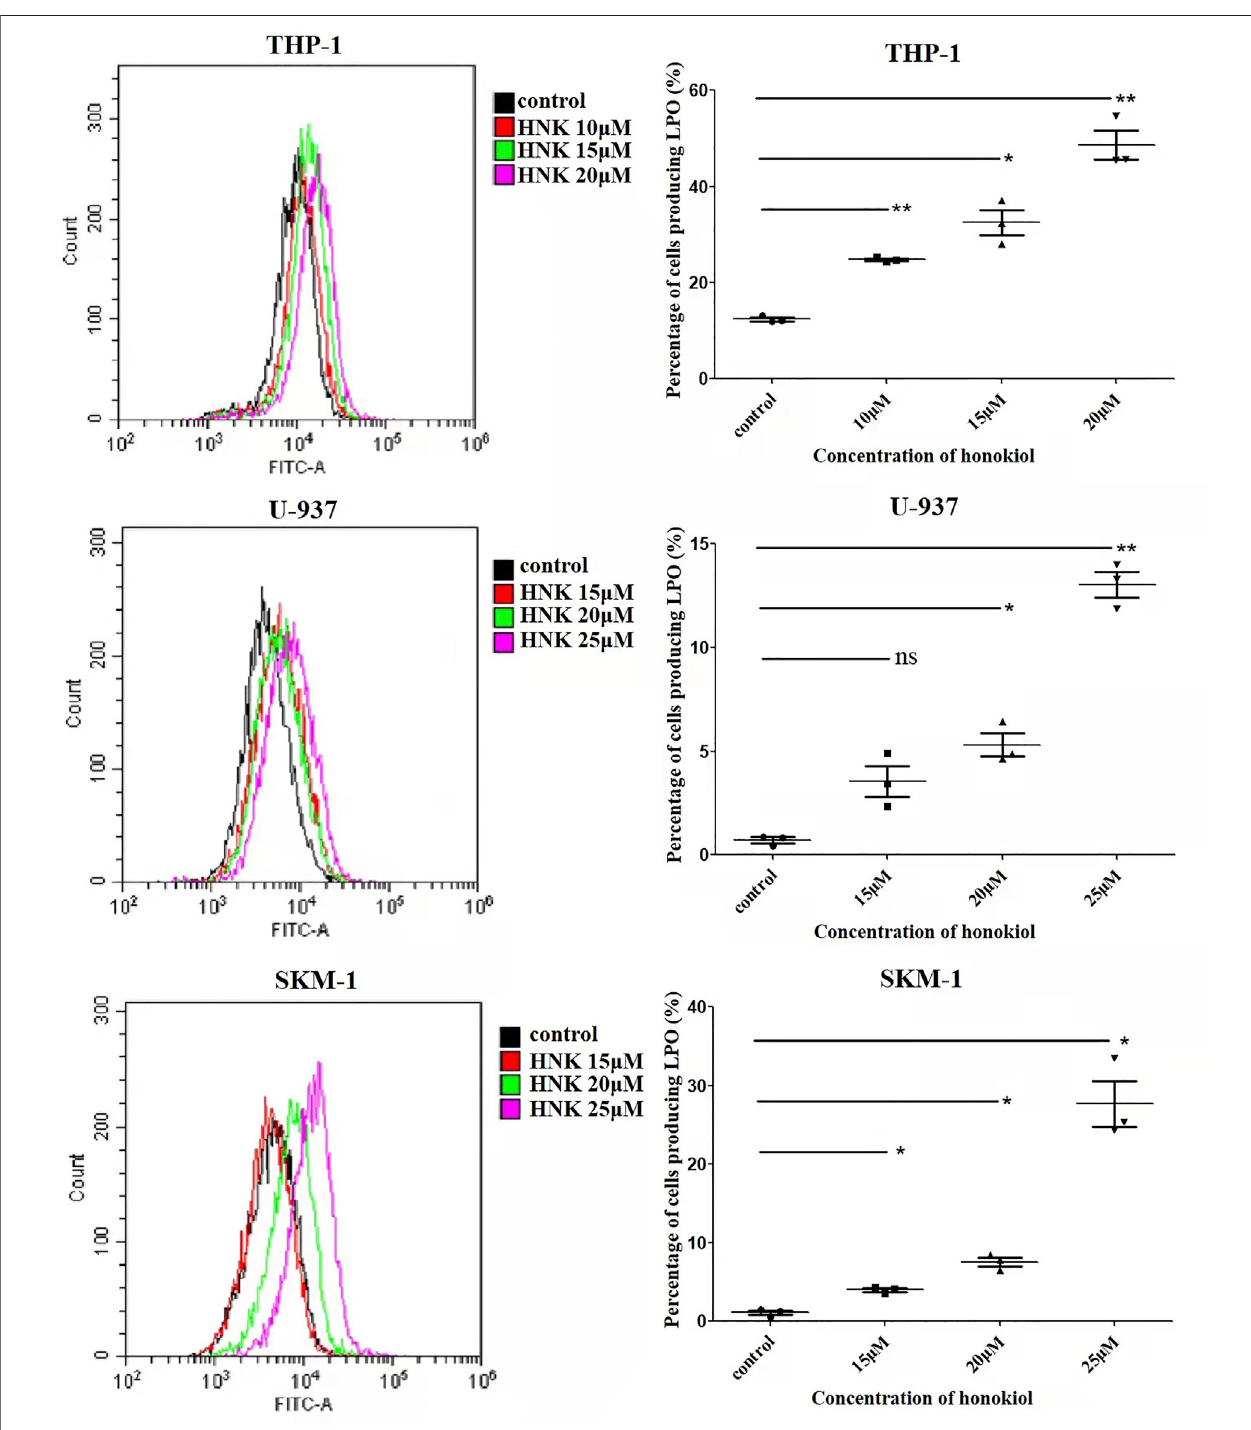
FIGURE 6 | Effects of honokiol on lipid peroxidation in THP-1, U-937, and SKM-1 cells. The cells were incubated with different concentrations of honokiol for 24h, then liper fl uo was added for fl ow cytometry analysis. Statistical analysis of lipid peroxide was presented as scatter plots (*, p < 0.05; **, p < 0.01).